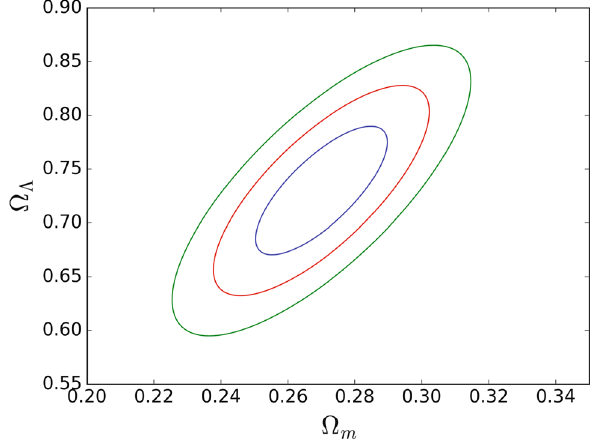
Fig. 13 The constraining of undulant universe for 3-year-observation simulation. The FoM is